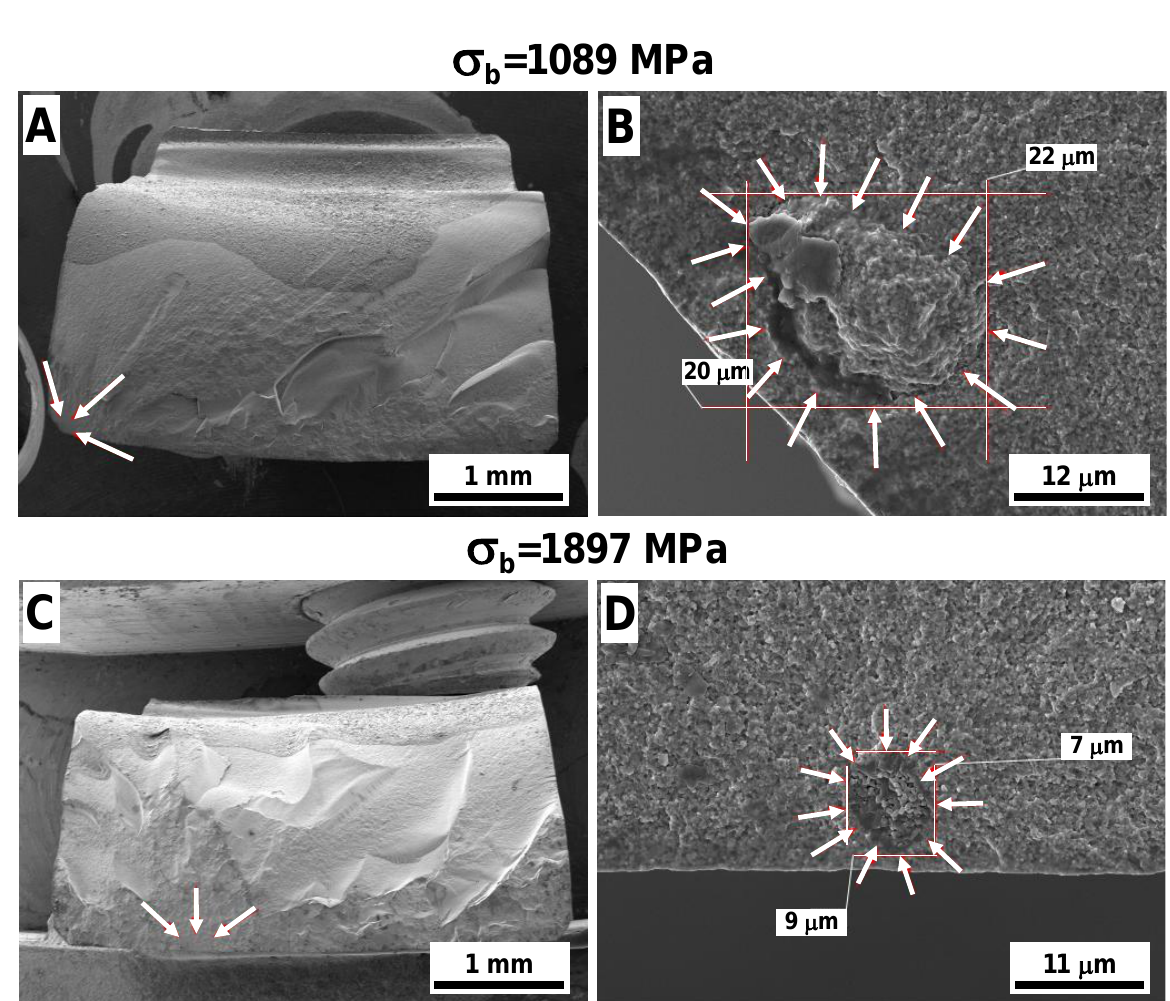
Figure 5. SEM micrographs of fracture surfaces of ATZ ceramic composite. The overall fracture surfaces of ATZ samples failed at 1089 MPa ( A ) and 1897 MPa ( C ), where locations of fracture origins are marked with arrows. The fracture origins of ATZ samples failed at 1089 MPa ( B ) and 1897 MPa ( D ). The dimensions of fracture origins in both cases are also shown.